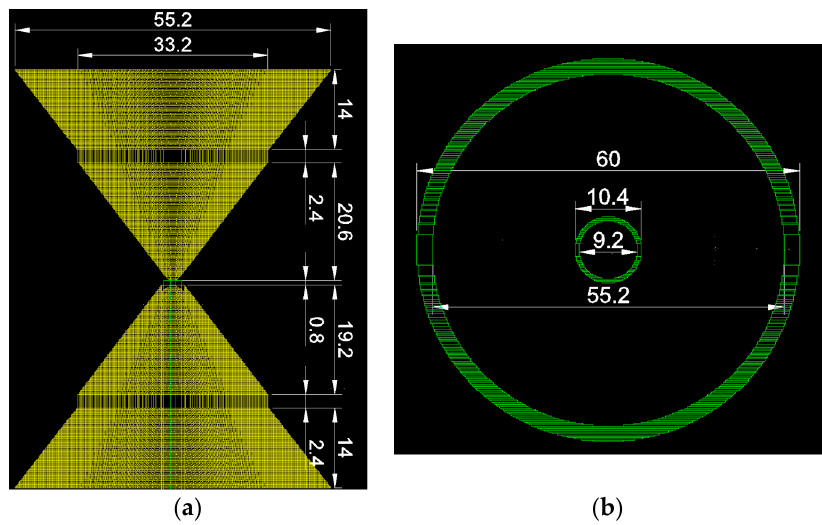
Figure 5. ( a ) The dimensions of modified cones in the base MBA, the total height of two cones is 73.4 mm, and the dielectric insert (green) sticks out at the end of the feed-line by 0.8 mm; ( b ) the top view of the discretized inner dielectric ring and the outer dielectric cover (unit is in mm).